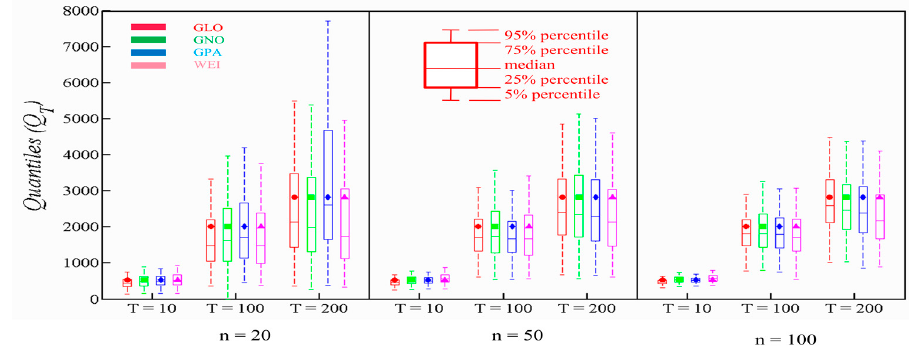
Figure 7. Boxplot for GLO, GNO, GPA and WEI for Ningolai river.